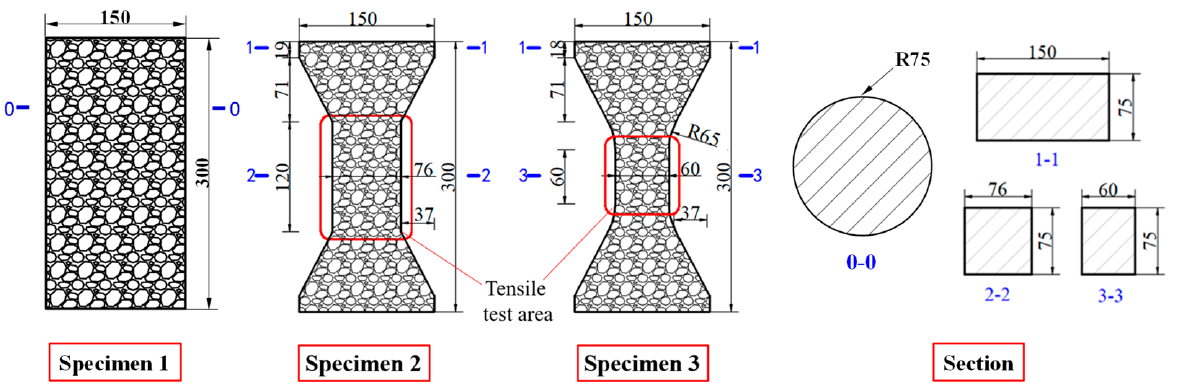
Figure 4. Shapes and sizes of specimens (unit: mm).